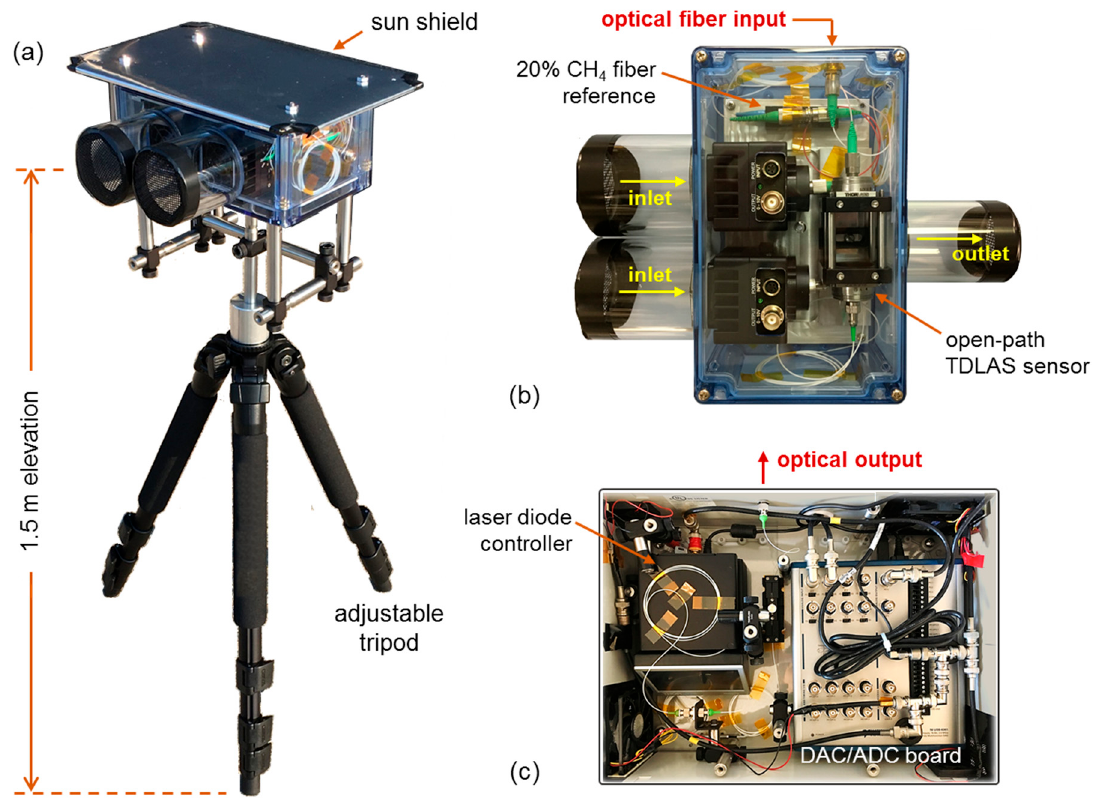
Figure 1. ( a ) The portable tunable diode-laser absorption spectroscopy (TDLAS) sensor mounted on a height-adjustable tripod (extensible up to 1.5 m). ( b ) Top view of the TDLAS sensor enclosure (V = 8 × 5 × 3 in. 3 ). The gas inlets draw in ambient air via the photodetector TEC fans, and is probed for CH 4 by the 5 cm open-path. ( c ) The TDLAS sensor control unit (V = 16 × 12 × 6 in. 3 ), which houses the (DFB) laser diode, polarization controller, and DAC/ADC acquisition board.